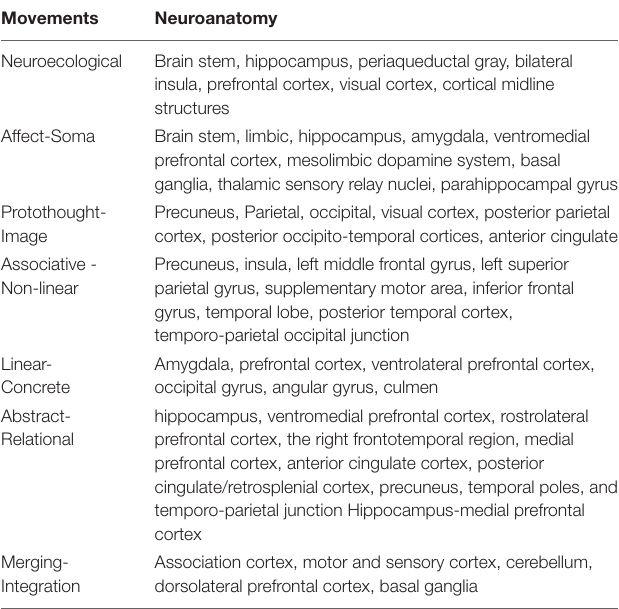
TABLE 2 | Seven temporal movements and neuroanatomical